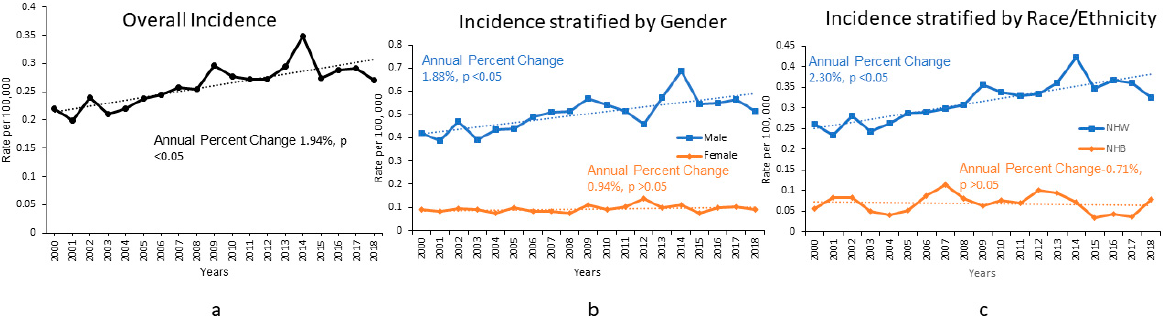
Figure 1. Incidence of Cutaneous Soft Tissue Sarcoma (CSTS) of Head and Neck. ( a ) Overall Incidence. ( b ) Incidence stratified by Gender. ( c ) Incidence stratified by Ethnicity. NHW: Non Hispanic White, NHB: Non Hispanic Black.